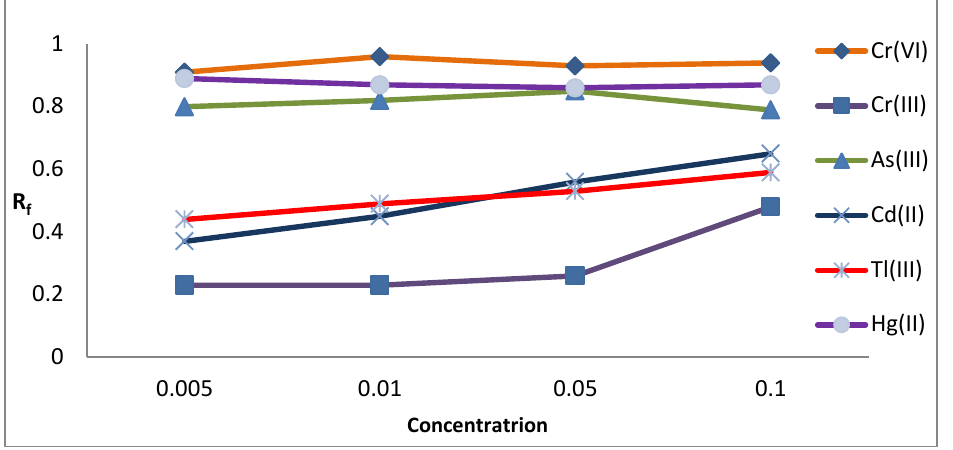
Figure 1. Effect of Concentration.